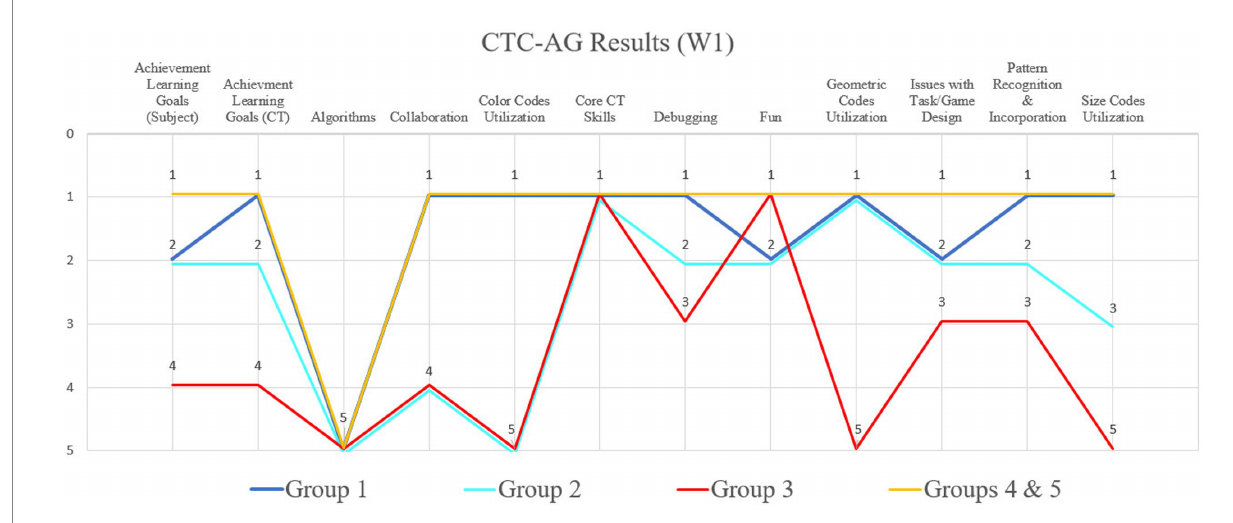
FIGURE 8 Results of the comparison of all five participating groups from workshop 1. The Y-axis shows the grades 1–5, according to the researcher, and the X-axis is showing excerpts of the CTC-AG